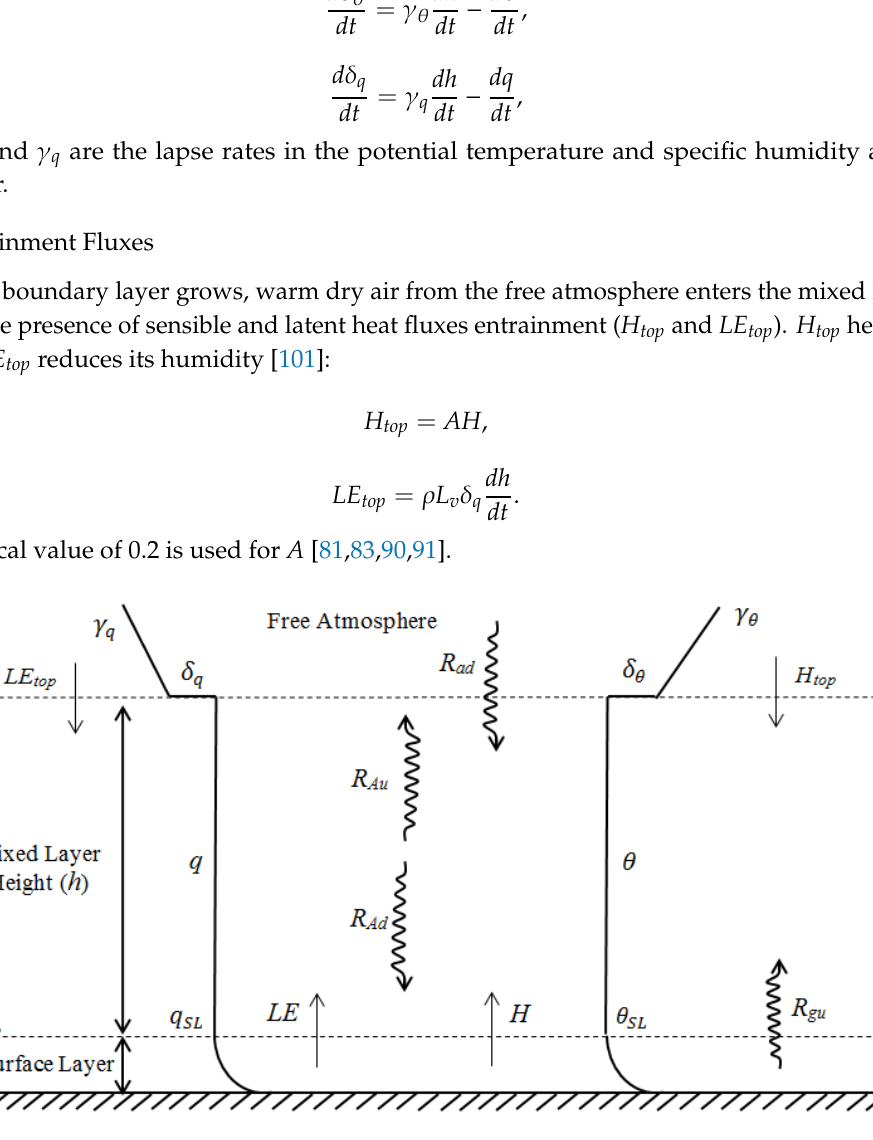
Figure 1. Idealized profiles of the potential temperature ( θ ) and specific humidity ( q ) in the atmospheric boundary layer (ABL), and corresponding fluxes.